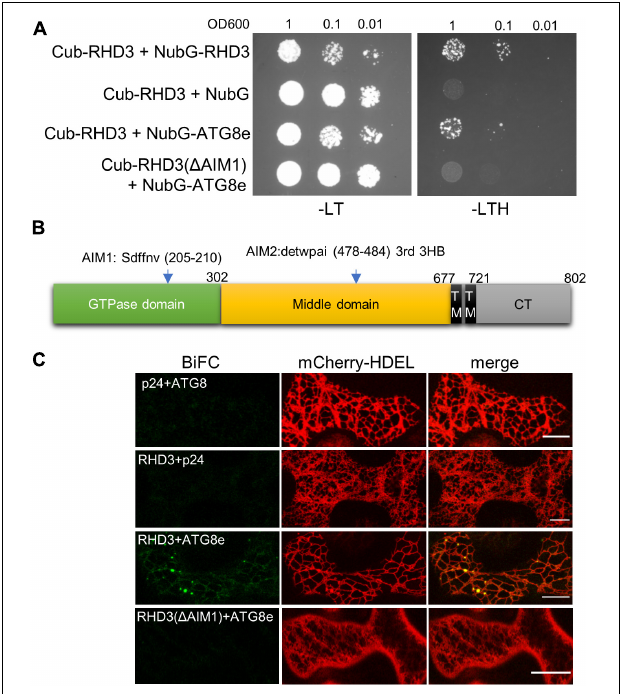
FIGURE 5 | ROOT HAIR DEFECTIVE3 (RHD3) but not RHD3( (cid:49) AIM1) interacts with ATG8. (A) The interaction between RHD3/RHD3( (cid:49) AIM1) and ATG8e revealed by the split ubiquitin system (SUS) of yeast two-hybrid (Y2H). RHD3 (row 1) but not RHD3( (cid:49) AIM1) (row 4) interacted with ATG8e. (B) The schematic presentation of the locations of two putative AIMs in RHD3 predicted by hfAIM. (C) The interaction of RHD3 RHD3( (cid:49) AIM1) and ATG8e in the bimolecular fluorescence complementation (BiFC) system. RHD3 (panel 3) but not RHD3( (cid:49) AIM1) (panel 4) interacted with ATG8e on the ER indicated by mCherry-HDEL. Scale bars = 10 µ m.